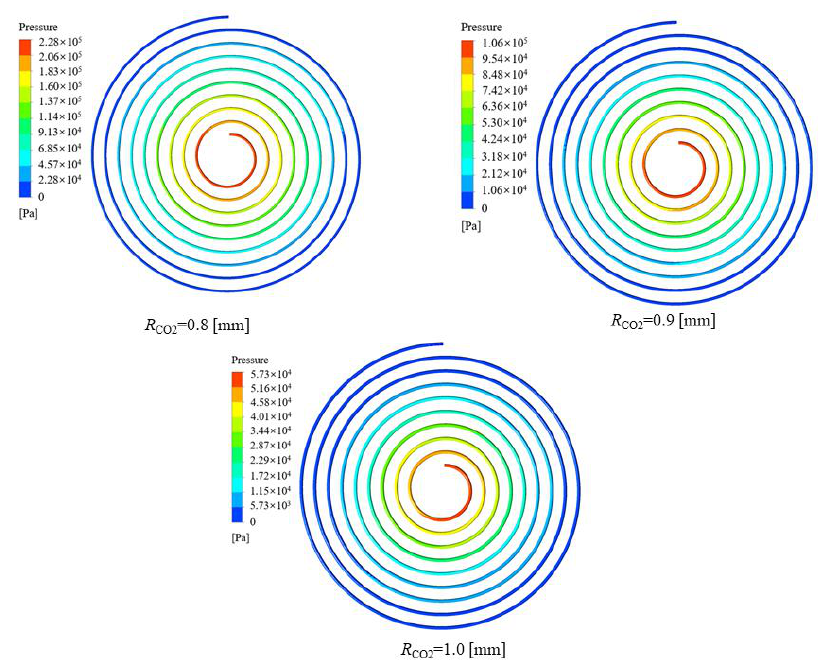
Figure 21. The pressure contour of CO 2 at different channel radiuses.